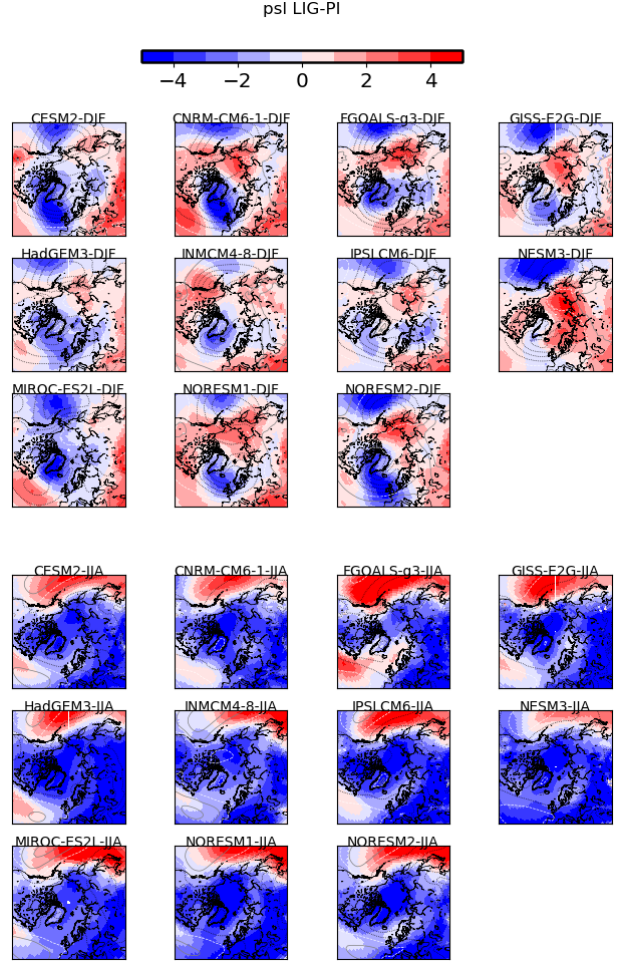
Figure 11. Anomalies (LIG–PI, hPa, shading) in mean sea level pressure for DJF (top plots) and JJA (bottom plots). Contours in- dicating PI values are superimposed: values every 5hPa, 1005hPa isobar in white, black contours for lower values and grey contours for higher values.